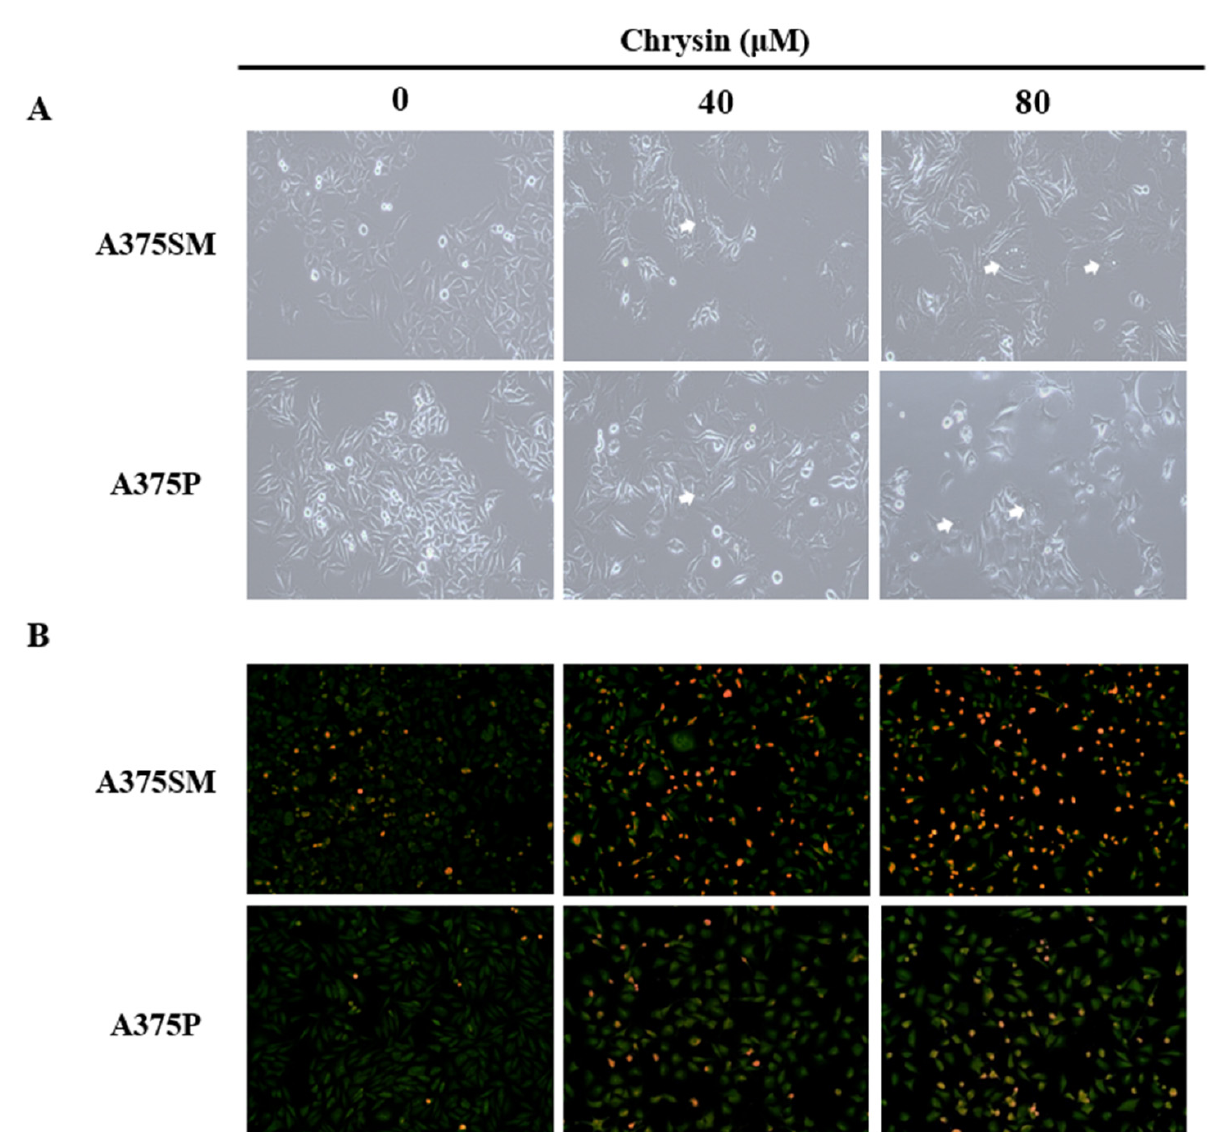
Figure 5. Chrysin induced autophagic vacuole formation in A375SM and A375P human melanoma cancer cells. Cells were treated with the indicated concentrations of chrysin for 24 h. ( A ) Morpho- logical changes were observed under phase-contrast microscopy. The white arrow indicates the autophagic vacuoles. ( B ) Cells were stained with 5 µ g/mL acridine orange to detect acid vesicle organelles and observed using a fluorescence microscope. The cytoplasm and nucleus fluoresce green and the acidic vesicular organelles fluoresce red.